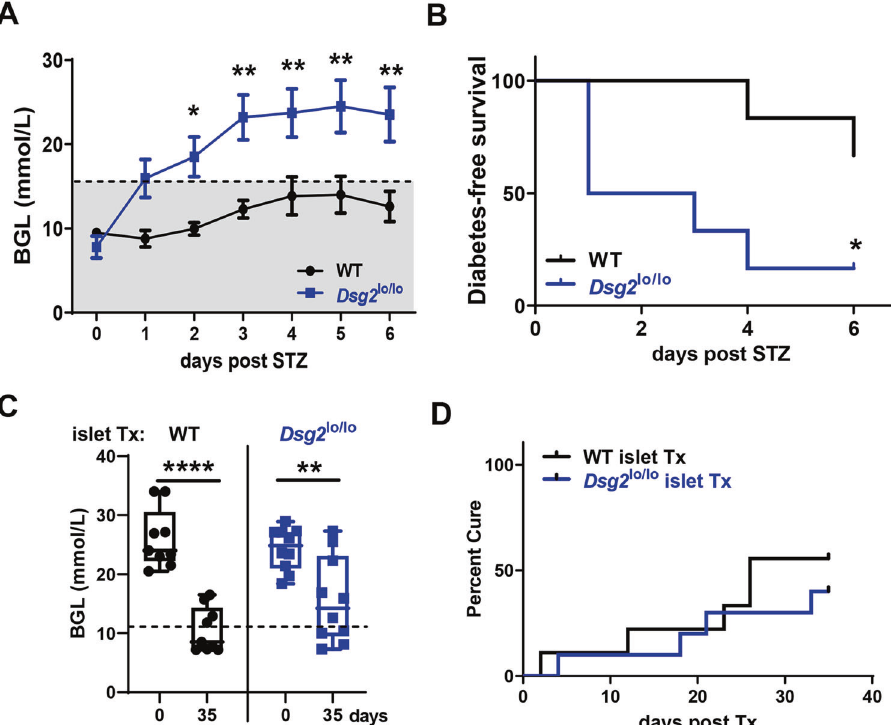
Fig. 6 Comparison of STZ-induced diabetes in WT and Dsg2 lo/lo mice and response of diabetic WT mice to islet transplantation. A WT and Dsg2 lo/lo mice administered STZ (185 mg/kg) were monitored daily for BGLs. A BGL ≥ 16 mmol/L (black dotted line) indicates the diabetic cut off value with the grey shaded box indicating a normal BGL range. Results are mean ± SEM, n = 8 – 9 mice per group, * p < 0.05 & ** p < 0.01 vs WT. Area under the curve quanti fi ed and presented as mean ± SEM, n = 8 – 9 mice per group, ** p < 0.01 vs WT. B From A, percentage of mice that became diabetic over time, *p < 0.05 vs WT. C Diabetic C57Bl6/N control (WT, n = 9) mice were transplanted with marginal islet mass of 200 islets harvested from WT ( n = 5) or Dsg2 lo/lo ( n = 4) mice under the kidney capsule. BGLs in individual mice were recorded daily and up to 35 days post-transplantation. ** p < 0.01 vs day 0 BGL, **** p < 0.0001 vs day 0 BGL. D From C , percentage cure of diabetic mice transplanted with marginal mass of islets displayed as Kaplan – Meier curve, where two consecutive readings of ≤ 11.1 mmol/L was considered a cured